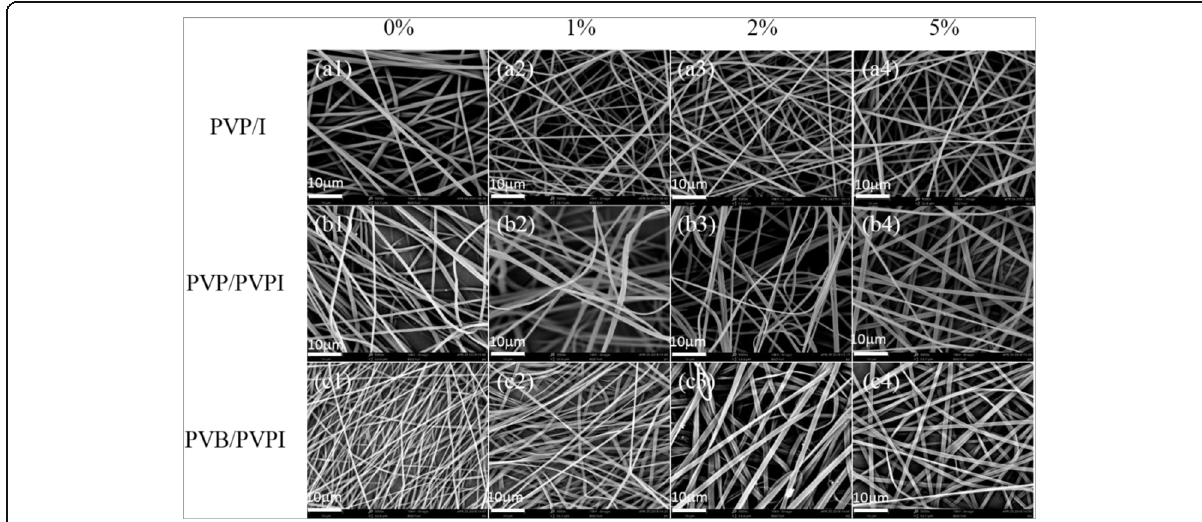
Fig. 2 SEM images of the as-spun PVP/I (a1 – a4), PVP/PVPI (b1 – b4), PVB/PVPI (c1 – c4) fibers with I or PVPI concentrations of 0%, 1%, 2%, and 5%,